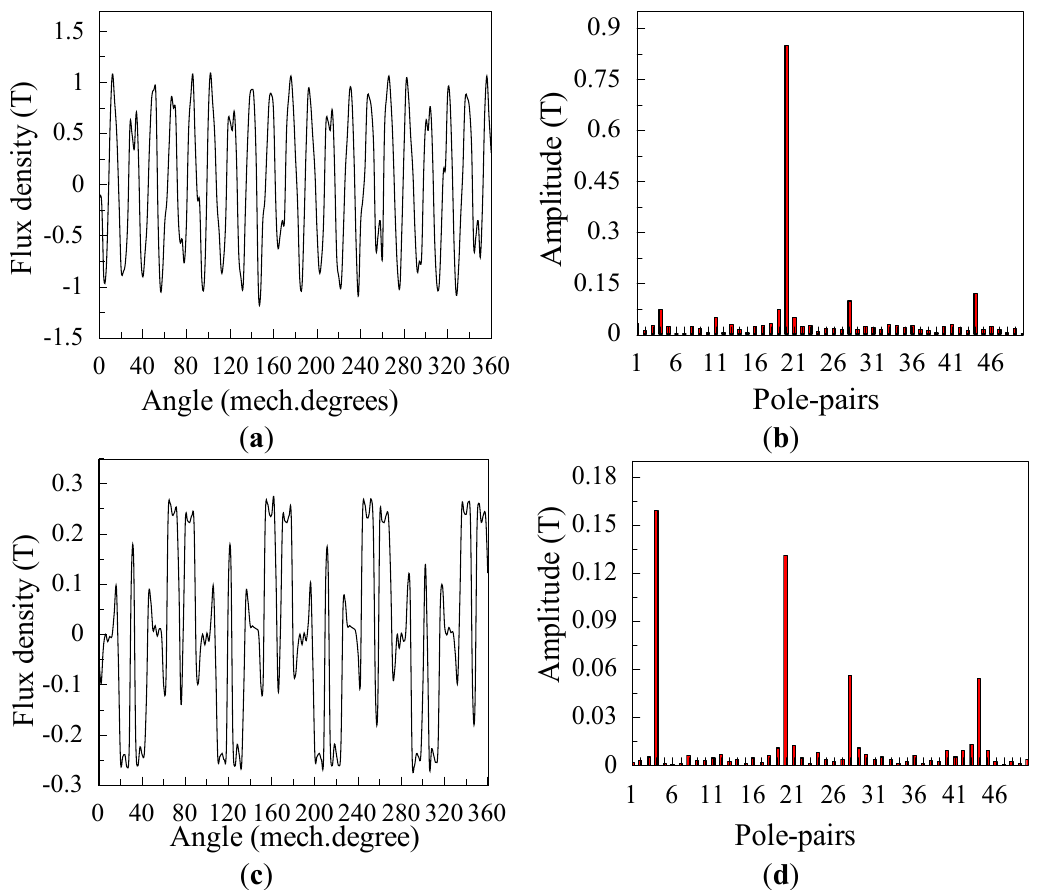
Figure 18. Axial flux density waveforms due to the permanent magnet rotor, in two air gaps and corresponding space harmonic spectra: ( a ) axial flux density waveform in the air gap adjacent to the permanent magnet rotor; ( b ) the space harmonic spectrum in the air gap adjacent to the permanent magnet rotor; ( c ) axial flux density waveform in the air gap adjacent to the stator; and ( d ) the space harmonic spectrum in the air gap adjacent to the